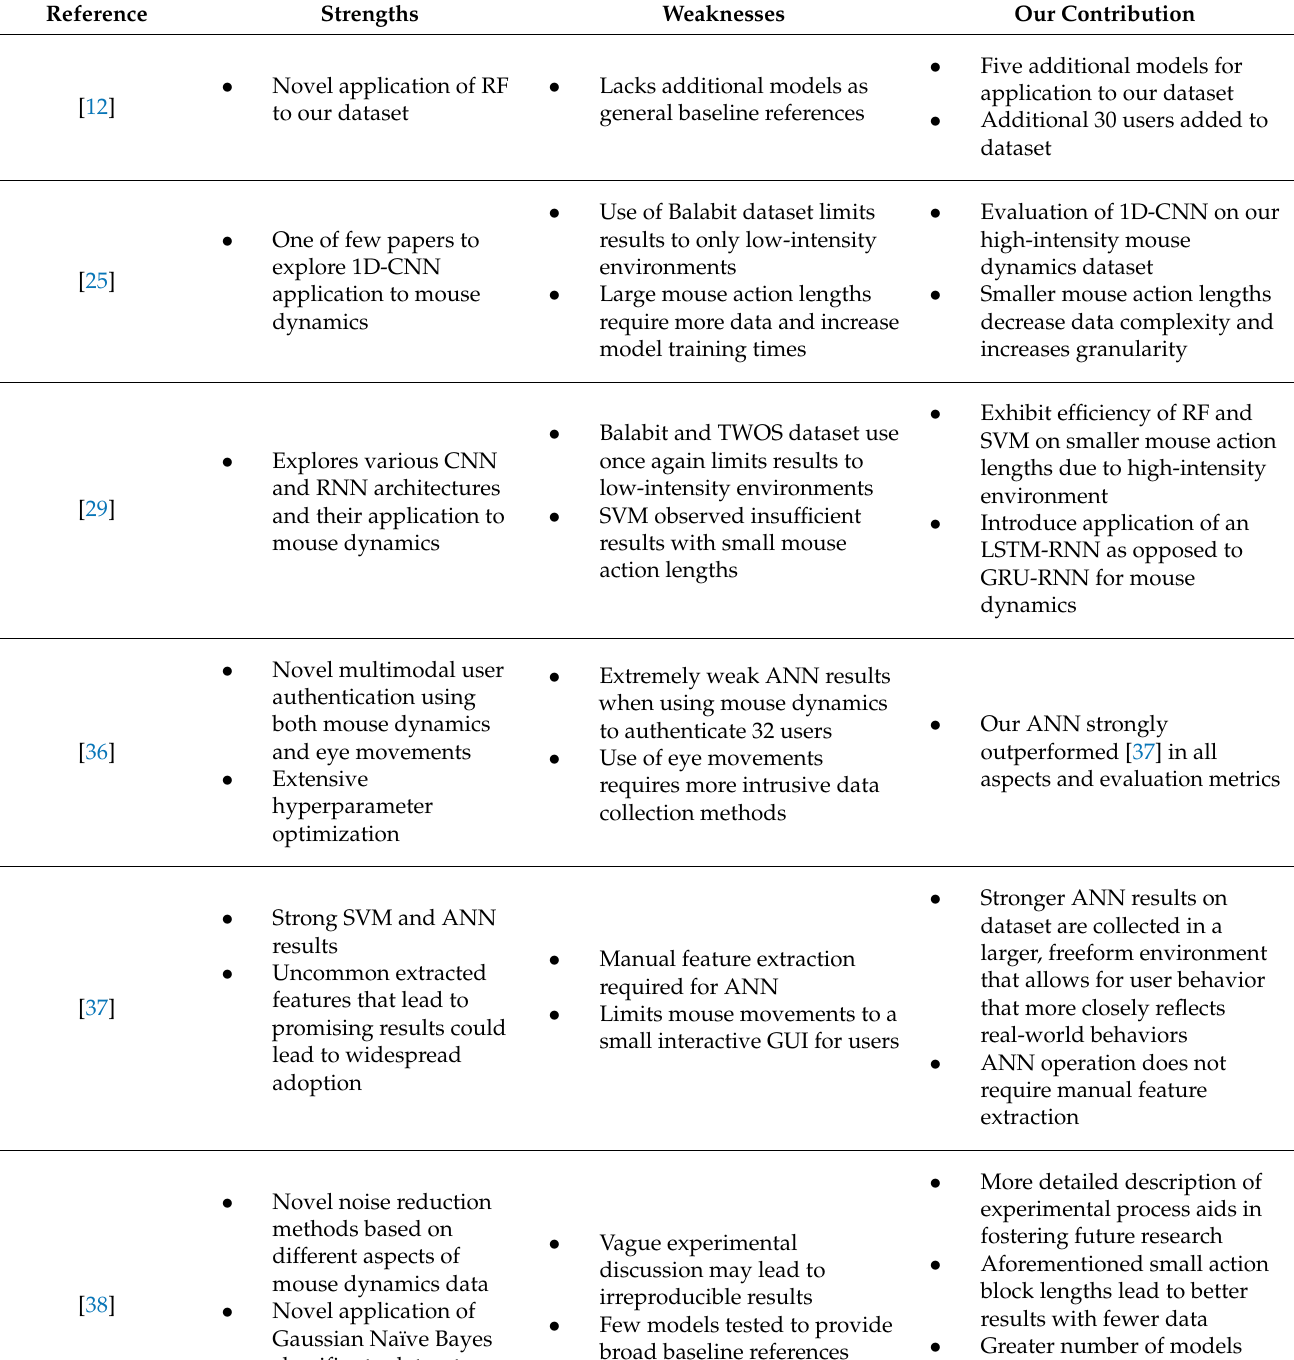
Table 8. Comparison of previous literature and our novel